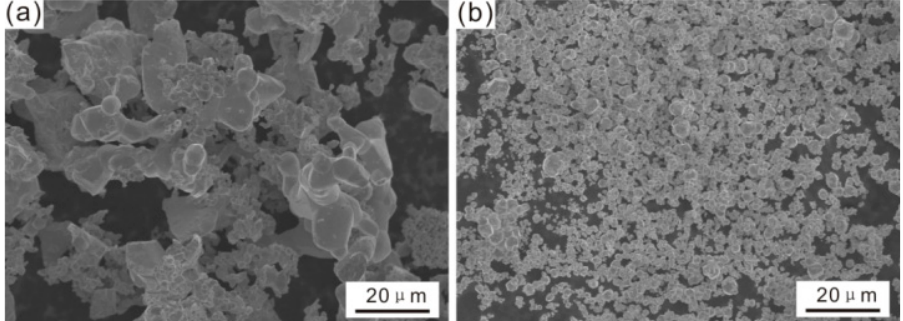
Figure 1. Micrographs of Ta ( a ) and W ( b ) raw powders. Table 1. Characterization and chemical composition of raw materials.